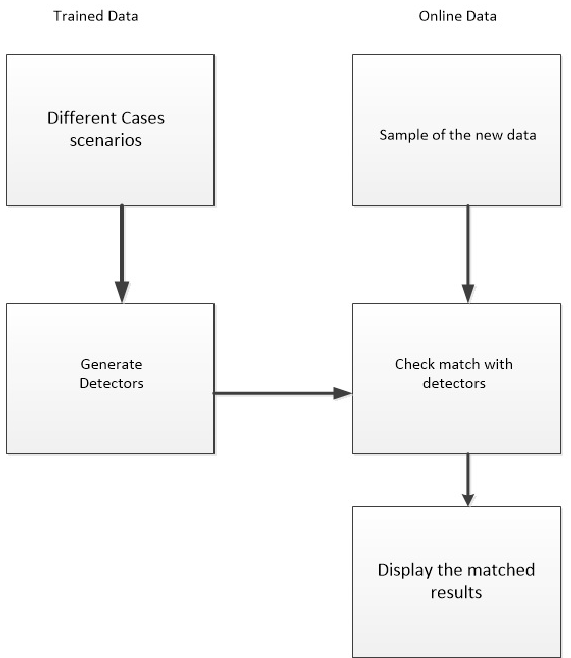
Figure 3. Detailed model of artificial immunity technique based wind speed estimation.